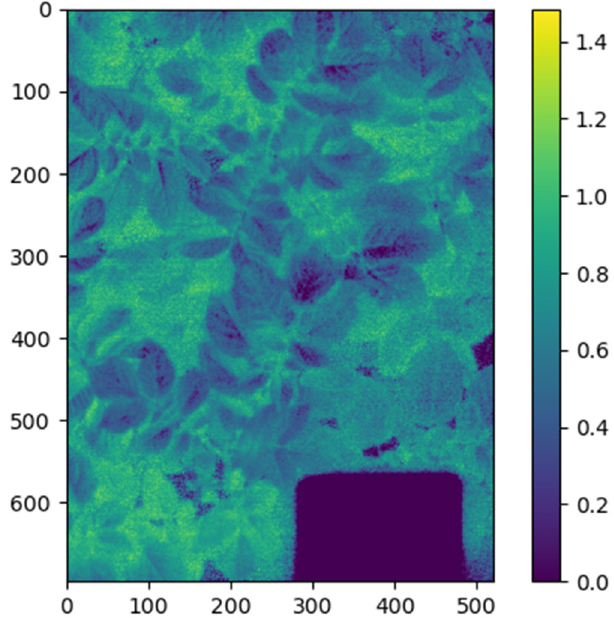
Figure 3. SAVI greater than 0.3 to detect leaves. From the image campaign at the tubers differentiation phenological stage, 64 images were acquired to be used for the machine learning algorithms (stressed and control plants) with water stresses that range from 3 to 20 days.